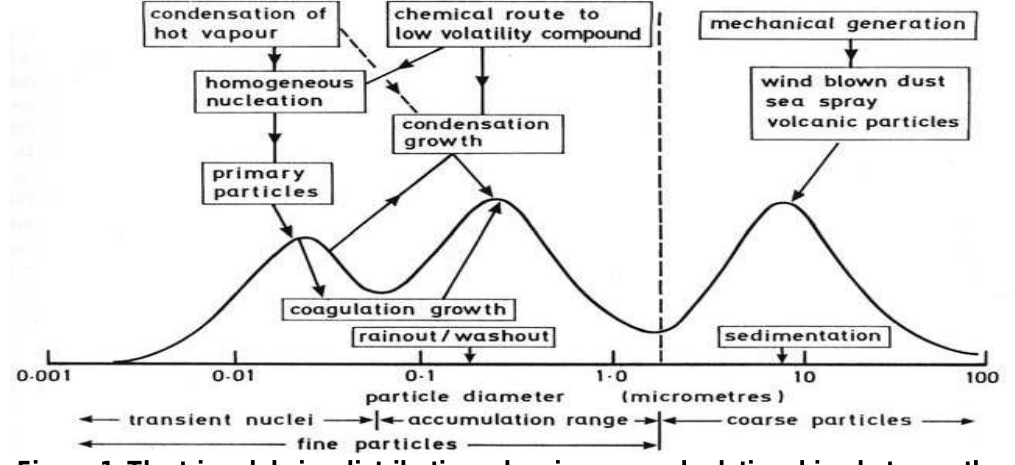
Figure 1. The trimodal size distribution, showing general relationships between the three common size ranges and the particle sources Source: Tiwary, Colls